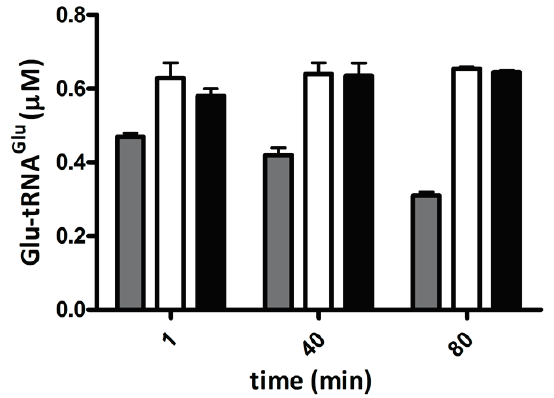
Figure 4. Protection of Glu-tRNA 2Glu by elongation factor Tu (EF-Tu) against deacylation. Remaining Glu-tRNA 2Glu over time was determined in the presence of EF-Tu, treated with 500 μ M H 2 O 2 (black bars) or untreated (open bars) at 37 °C. The spontaneous deacylation of Glu-tRNA 2Glu without EF-Tu was use as a control (gray bars).